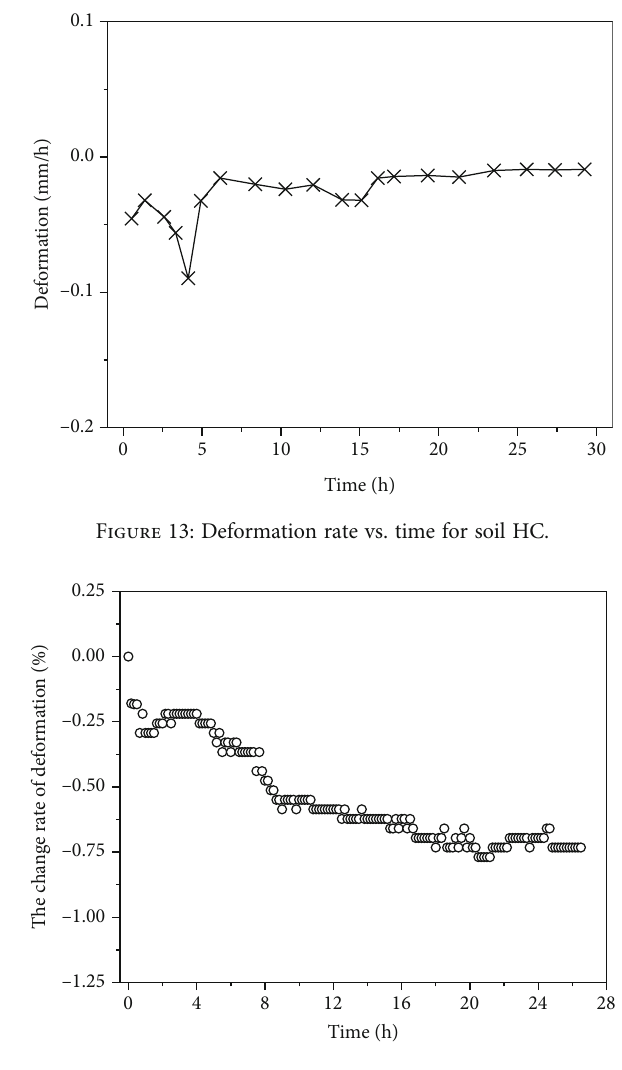
Figure 14: The change rate of deformation vs. time for soil HS.